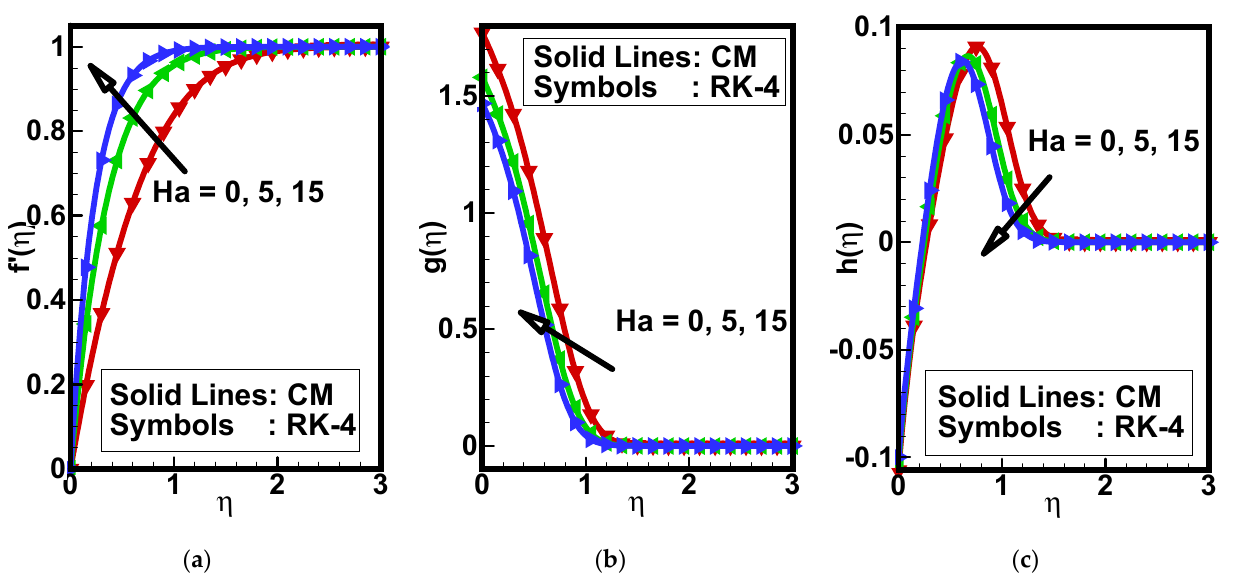
Figure 5. Comparison between the obtained solution with the collocation method (CM) and fourth- order Runge–Kutta (RK-4) of the dimensionless ( a ) velocity, ( b ) temperature, and ( c ) concentration profiles as varying Ha .